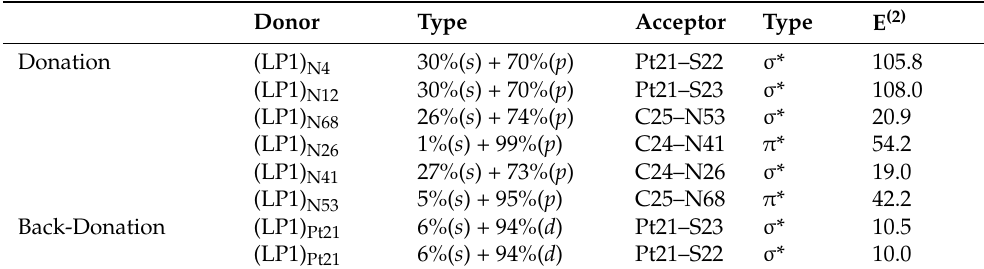
Table 9. Second-order perturbation energies (E (2) ) for charge transfers from donor to acceptor orbitals in [Pt(BPT)(Bipy)] ( 7